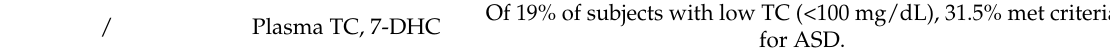
Plasma TC, 7-DHC and 8-DHC at baseline and after 8-DHC